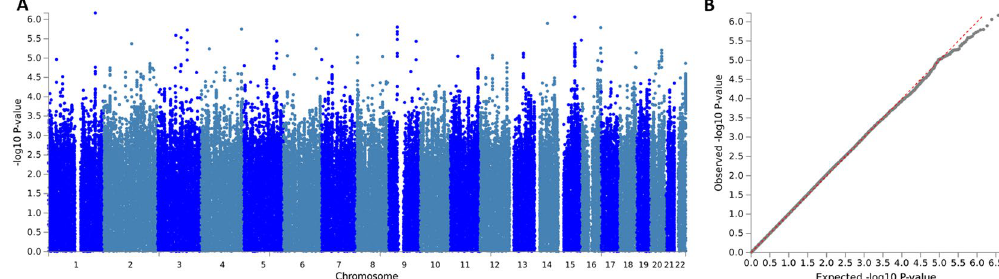
Figure 2. Manhattan plot and quantile-quantile plot of the GWAS of the Triangles Task ( A ). Manhattan plot of the Triangles Task GWAS (top). Y-axis is the -log 10 (P-value) for each SNP. X axis is the Chromosome ( B ). Quantile-quantile plot of the Triangles Task GWAS (bottom). The LD score regression intercept = 0.99 ±